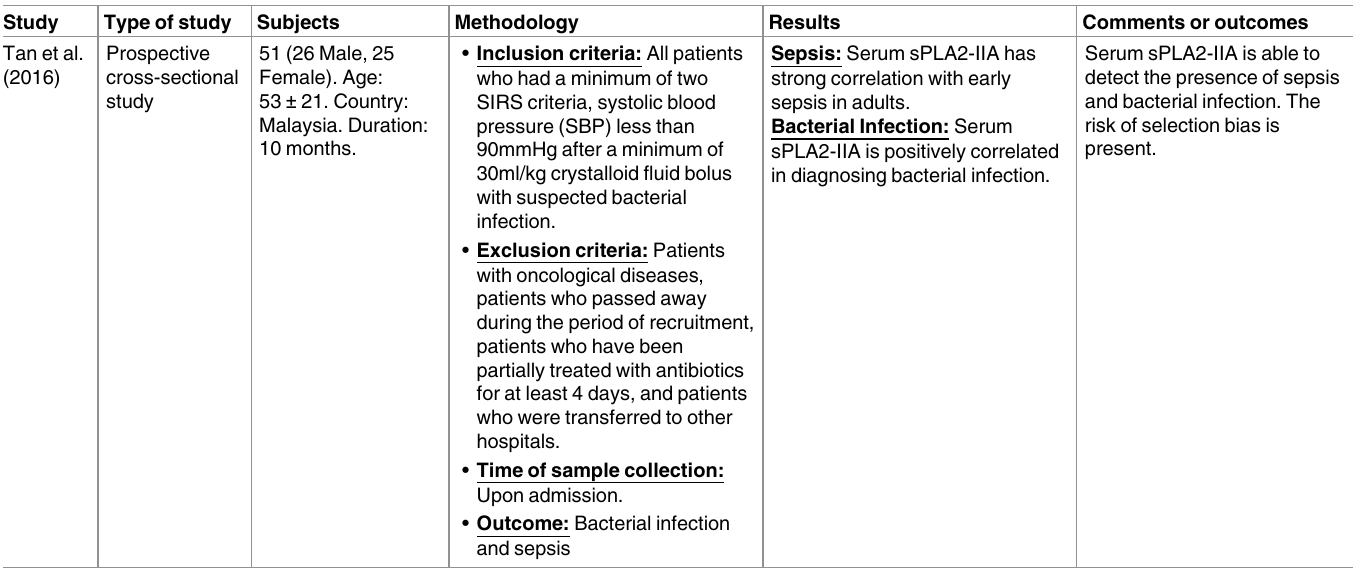
strong correlation with early sepsis in adults. Bacterial Infection: Serum sPLA2-IIA is positively correlated in diagnosingbacterial infection.